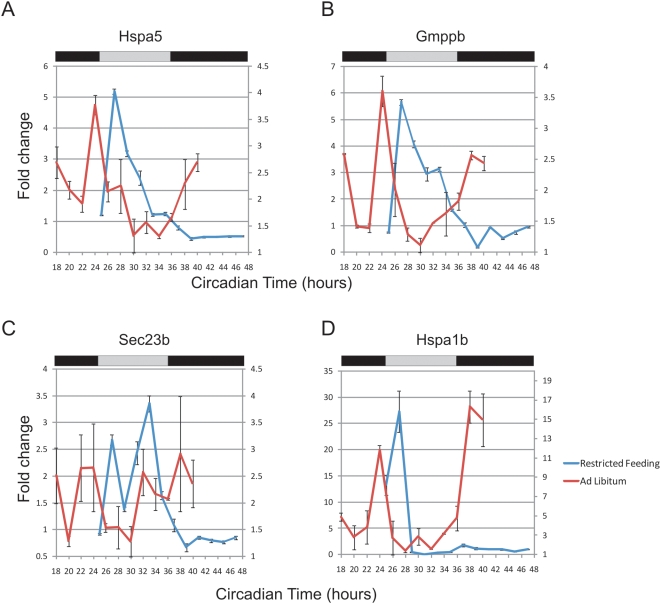
Restricted feeding changes the periodicity of 12 h rhythms.Mice were held in a restricted feeding paradigm (see Methods) and liver samples were collected every 2 h. Quantitative PCR was used to assess the transcriptional profile of eight genes: Hspa5 (A), Gmppb (B), Sec23b (C), Hspa1b (D), as well as Gramd3, Creld2, Gosr2 and Ints2 (data not shown). When compared to samples from ad libitum fed mice (red traces, right axis), restricted feeding samples (blue traces, left axis) showed only a single peak of expression over the course of a complete day (Error bars are +/−S.E.M.).